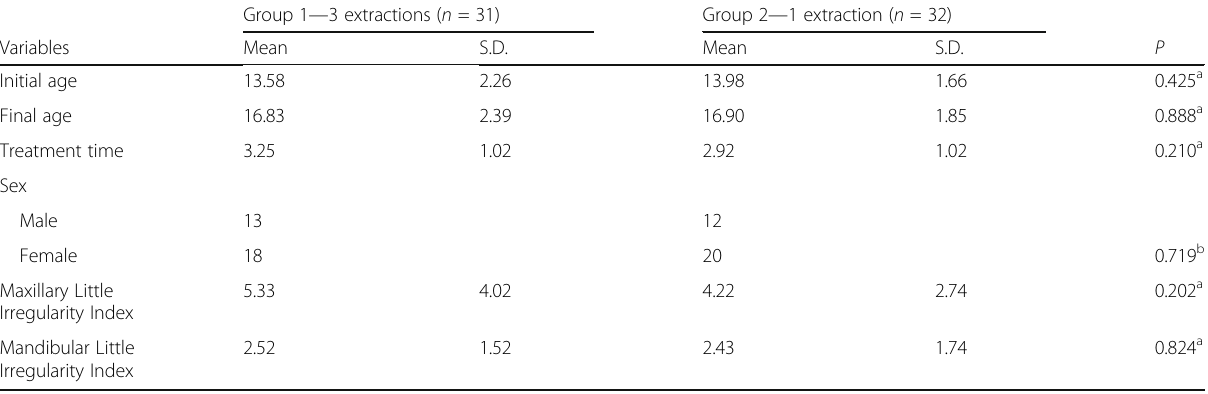
Table 2 Intergroup baseline comparability ( t and Chi-square